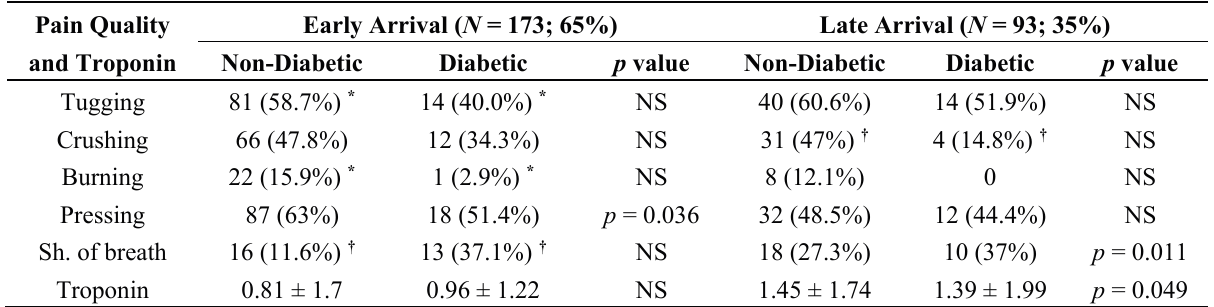
Table 3. Pain quality and troponin levels. Differences within early- and late-arrival groups. Pain